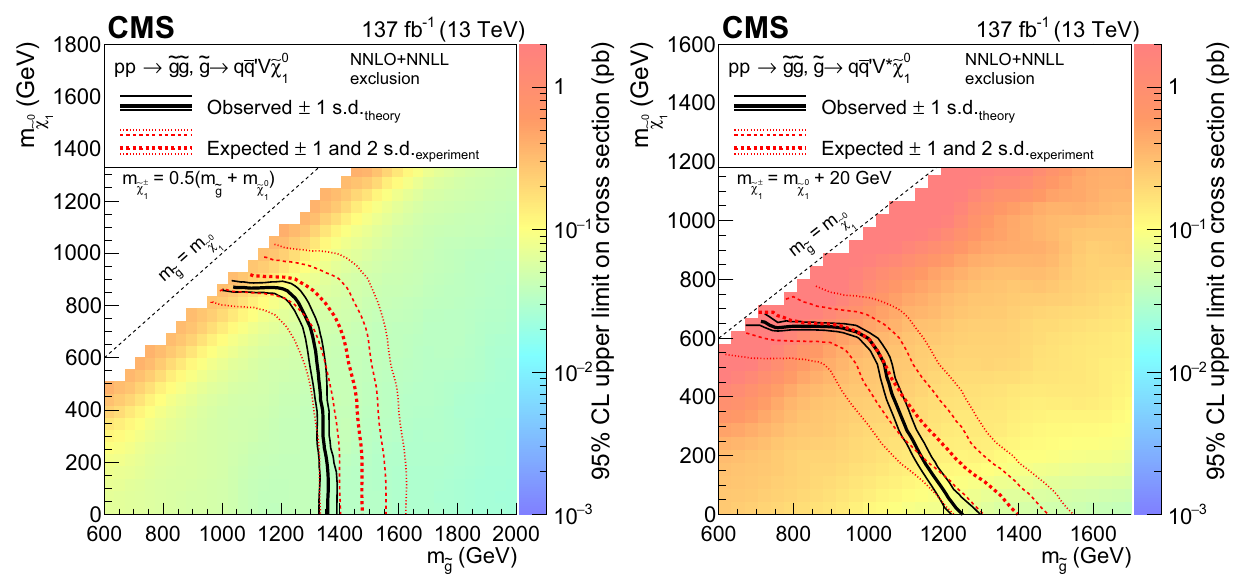
= 0 . 5 ( m ˜ + m ) (left) and with ˜ χ 0 g 1 1